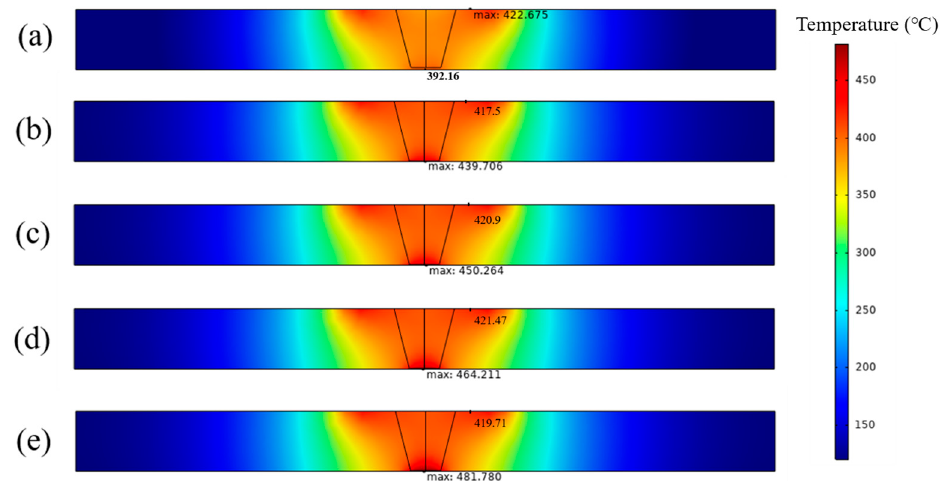
Figure 14. Temperature field of weld cross-section at different lengths of pin (1000 rpm, 120 mm/min, 6 mm thick workpiece) ( a ) 5.95 mm; ( b ) 5.96 mm; ( c ) 5.97 mm; ( d ) 5.98 mm; ( e ) 5.99 mm.